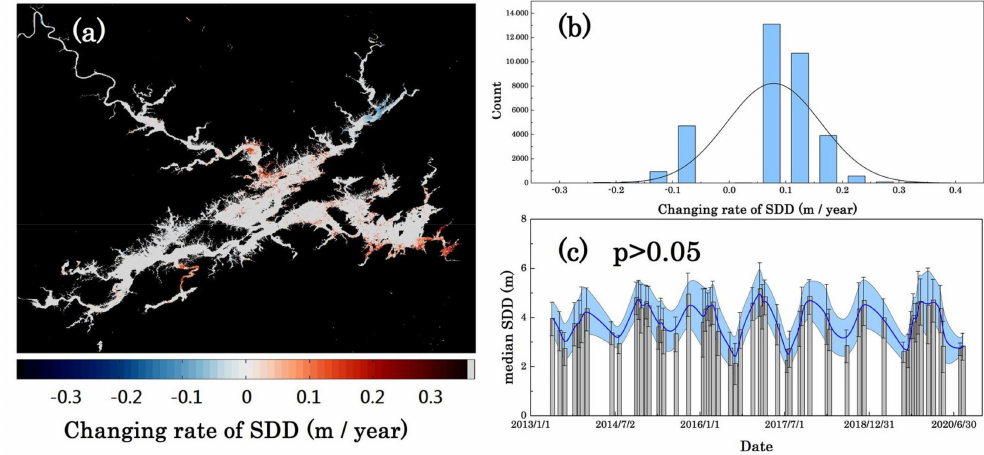
Figure 7. Variability of SDD in the Qiandao Lake during 2013–2020. ( a ) Areas with significant SDD change rates; ( b ) His- togram distribution of the significant SDD change rates; ( c ) Median SDD variability for the whole Qiandao